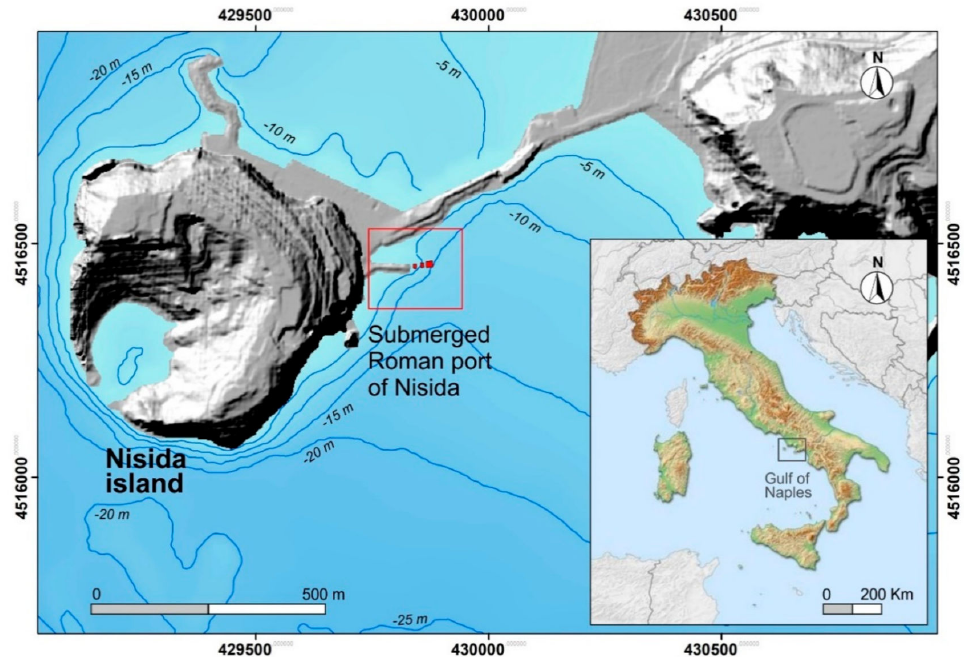
Figure 1. Location map of Nisida Roman harbour with the submerged archaeological structures in red. The shaded relief (altitude 45 ◦ , azimuth 315 ◦ ) in figure derives from a DTM with a spatial grid 2 m × 2 m. The Ministry of the Environment kindly provided the Lidar data used to calculate the DTM.